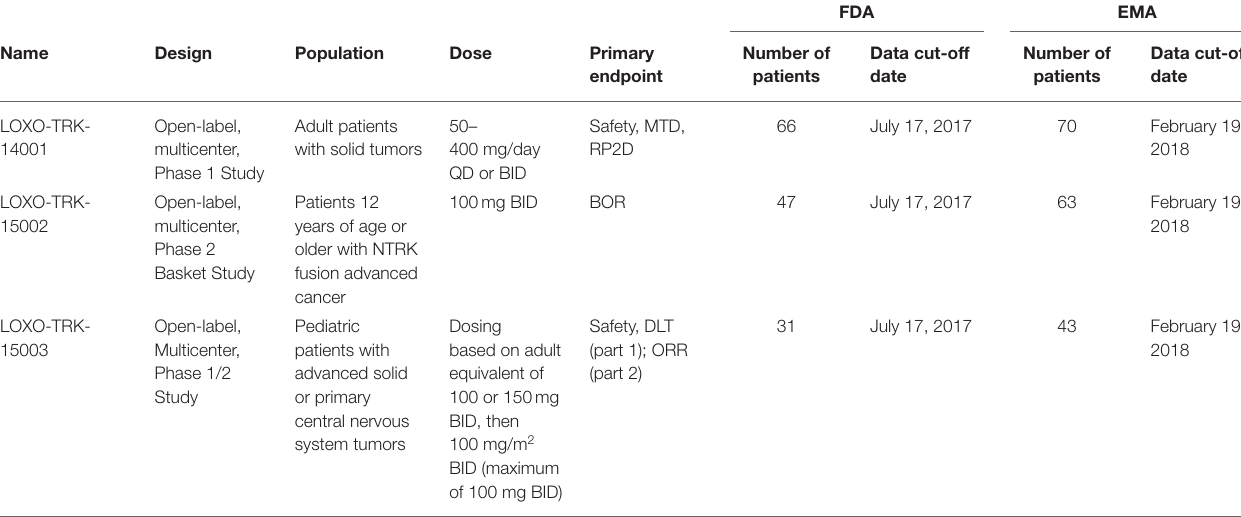
TABLE 2 | Clinical trials supporting the approval of larotrectinib for the treatment of NTRK tumors.